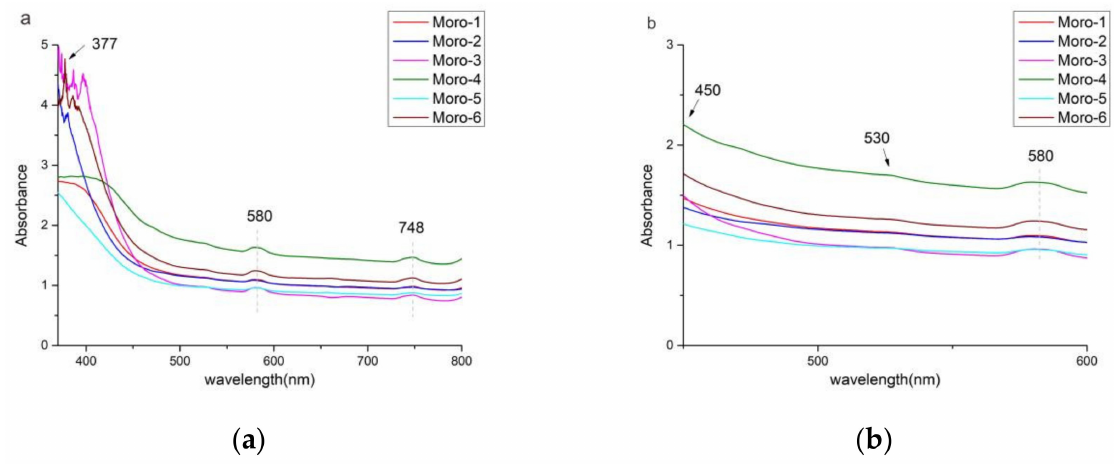
Figure 5. UV–VIS spectra of the Moroccan apatites. ( a ) From 360 nm to 800 nm. ( b ) From 450 nm to 600